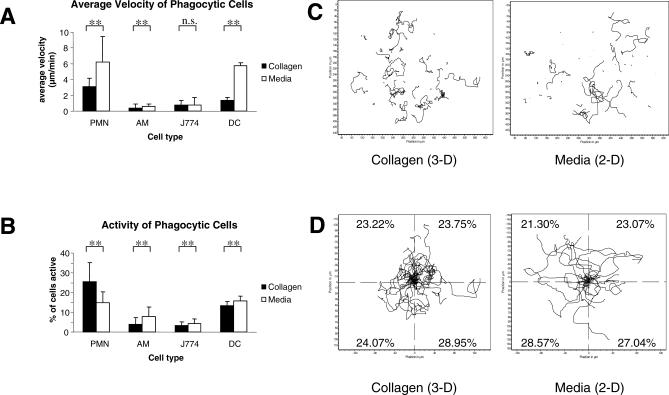
The Migration of Phagocytic Cells in 2-D and 3-D EnvironmentsUnstimulated cells (except J774 cells, which were stimulated overnight with 2.5 U/ml interferon-γ before use) were embedded along with A. fumigatus conidia within 3-D collagen matrices or within a 2-D liquid based chamber, and cell movements were recorded for 2 h by time-lapse video microscopy. The migration of 40 to 60 individual cells for each cell type was quantified by computer-assisted, single-cell tracking.(A and B) The average velocity (in μm/min) (A) and activity (percentage of migrating cells at a given time point) (B) were calculated from the tracks and are shown here as a comparison between different cell types. Data represent the average of three independent experiments.(C) Representative tracks of 40 PMNs were analyzed in a 3-D collagen matrix or in a 2-D media-based system.(D) The same cell tracks as depicted in (C) have been redrawn to artificially start at the center of the graph, and each individual step in each track was analyzed for its length and orientation within the four quadrants. This made it possible to measure the distance of all steps that were made into each quadrant. The numbers indicate the percentage of the total distance covered by all tracked cells in each of the four quadrants in 3-D and 2-D systems, showing almost random migration (perfect random migration would result in 25% distance in each quadrant). **, p < 0.01; n.s., not significant. Error bars represent standard deviation (SD).